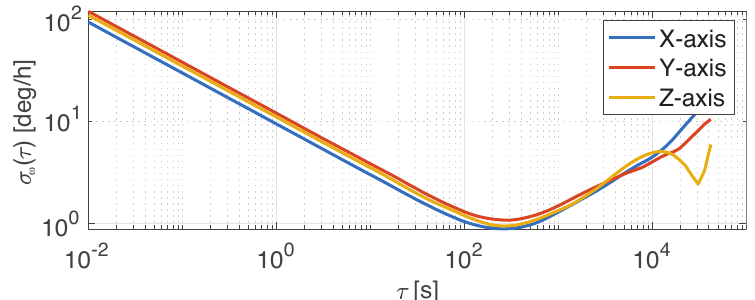
Figure 5. Allan variance, σ ω ( τ ) , for Memsense MS3025M